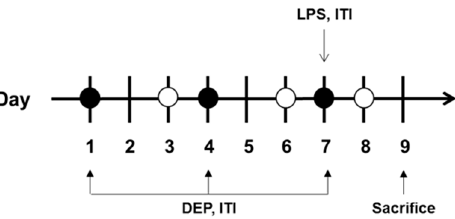
Figure 1. Diagram showing the in vivo experimental protocol. DEP, diesel exhaust particulate; LPS, lipopolysacharide; ITI, intratracheal injection.